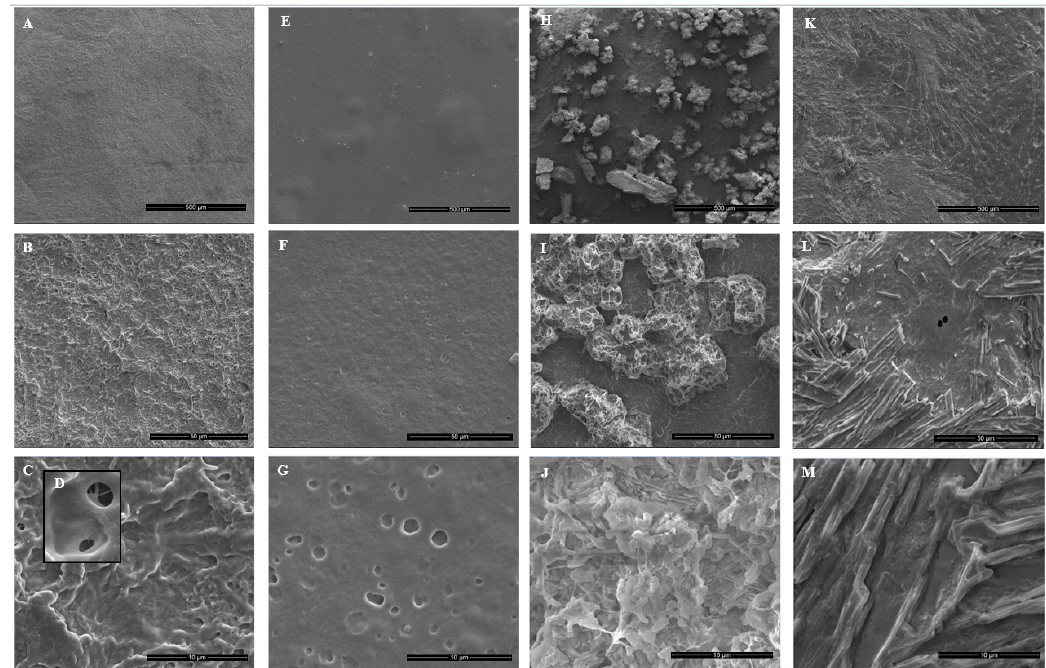
Figure 6. SEM images of neat PVA/PVP × 200 ( A ), 2000 ( B ), 10,000 ( C) and 40,000 ( D ), PVA/PVP/HP × 200 ( E ), 2000 ( F ) and 10,000 ( G ), PVA/PVP/thymol × 200 ( H ), 2000 ( I ) and 10,000 ( J ), and PVA/PVP/HP-thymol × 200 ( K ), 2000 ( L ) and 10,000 ( M ).